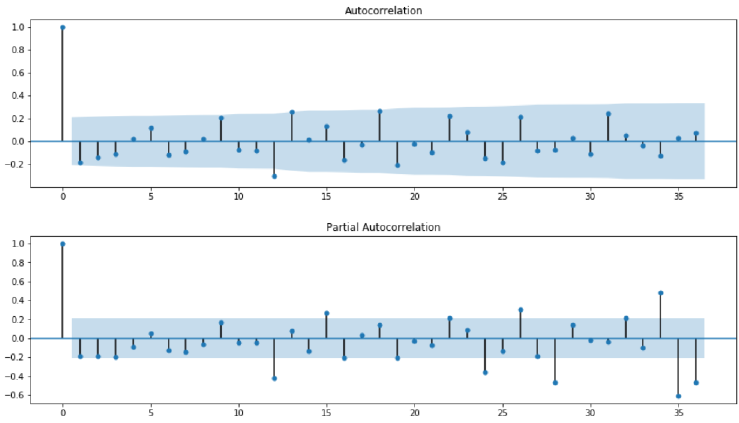
Figure 9. Autocorrelation and partial autocorrelation function